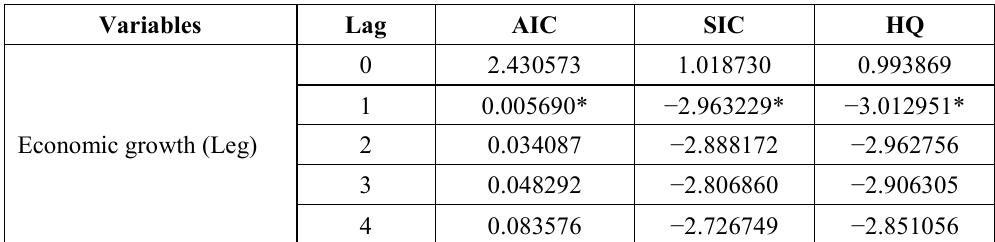
Table 4. Optimal Lag Selection Result for Economic Growth